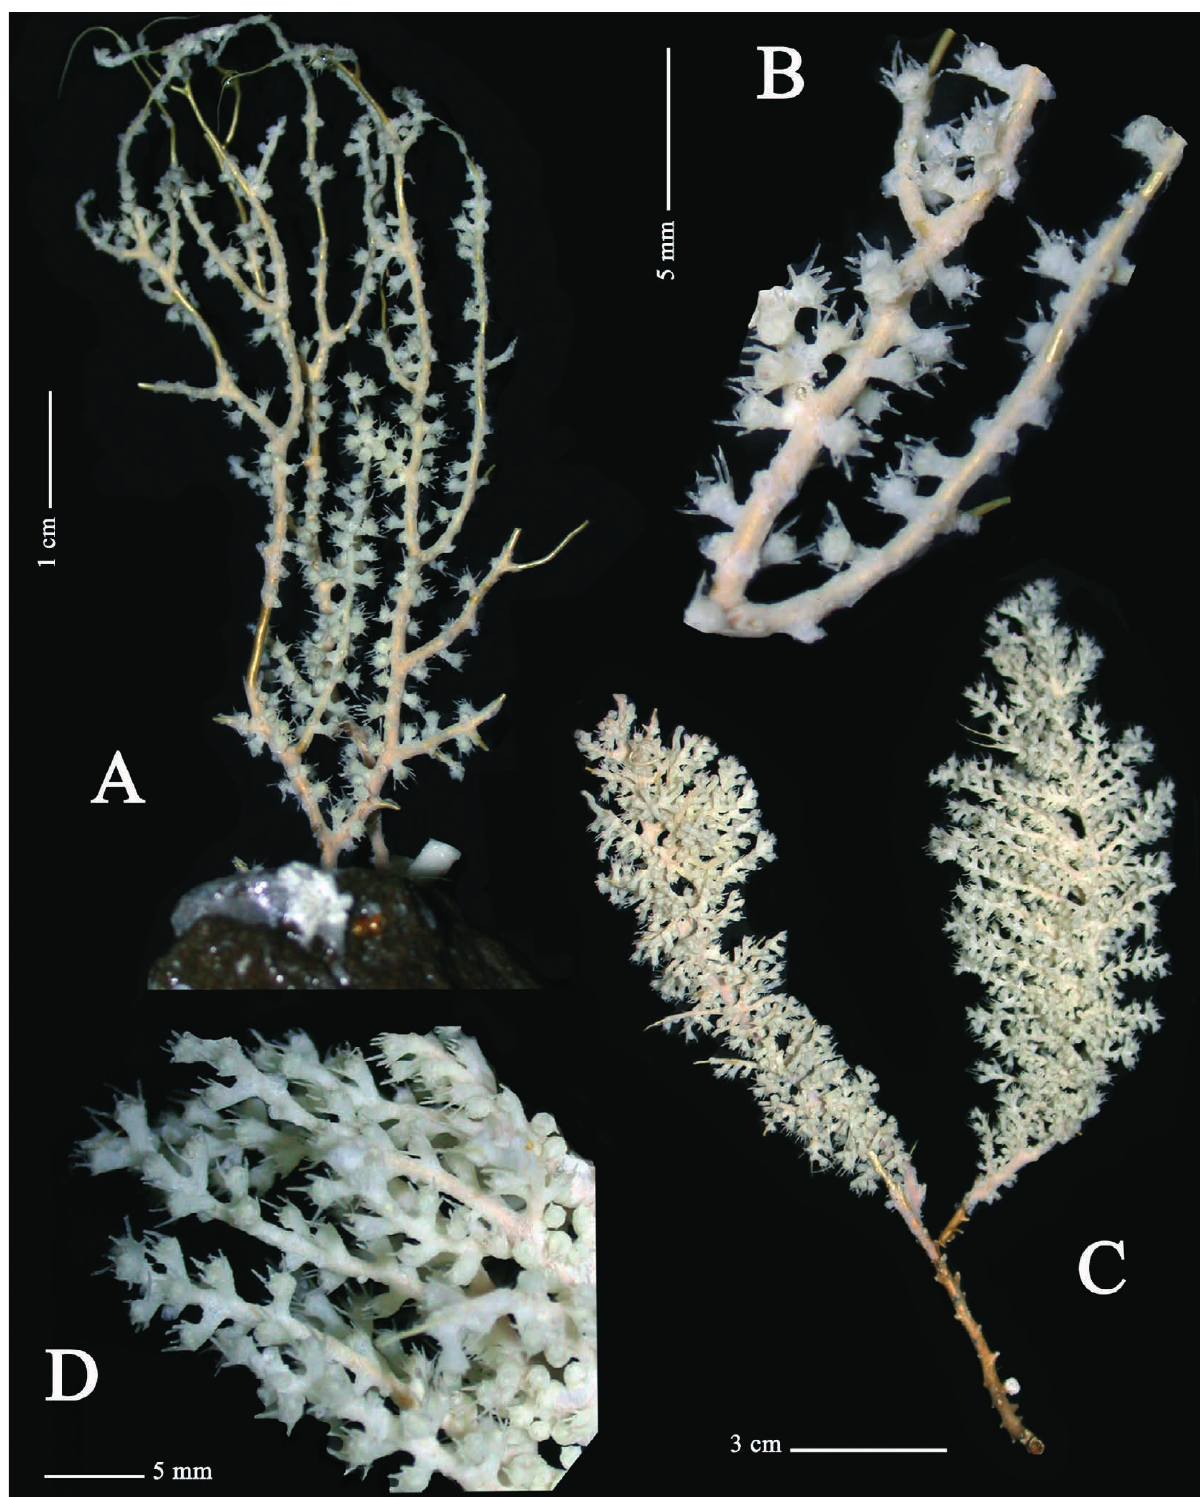
Fig . 2. – Thouarella bayeri n. sp., holotype ZiZMH c11738: a, whole colony; b, detail of a branchlet. Thoaurella sardana n. sp., holotype ZiZMH c11740: c, whole colony; d, detail of a